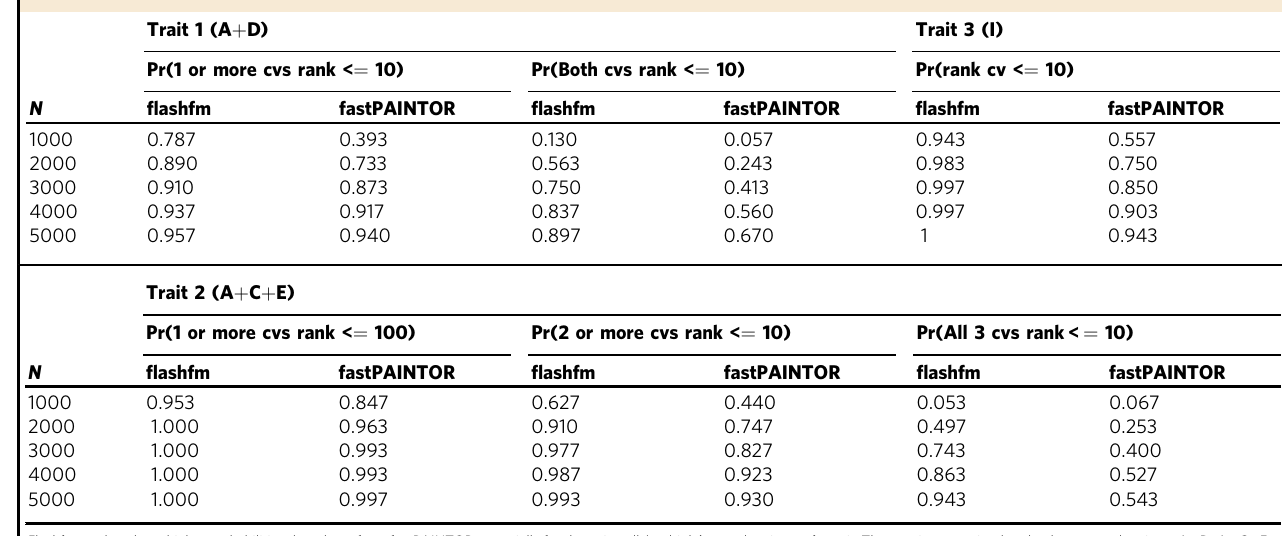
FlashfmtendstohavehigherprobabilitiesthanthosefromfastPAINTOR,especiallyfordetectingall(multiple)causalvariantsofatrait.ThreetraitsweresimulatedtohavecausalvariantsA + D,A + C + E, and I and trait correlation is 0.4. Sample size ranges from N = 1000 to 5000. The region has 345 SNPS and was simulated to mimic the LD structure of the IL2RA region, 10p-6030000-6220000 (GRCh37/hg19). Results are based on 300 replications.